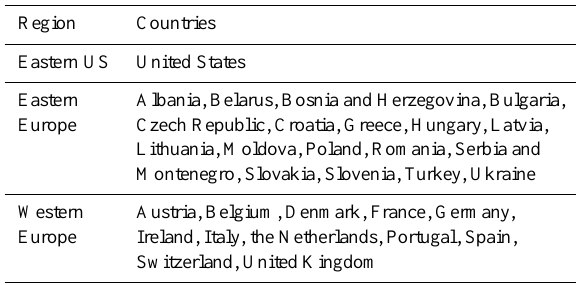
Table 2. List of countries included to calculate regional SO 2 emis- sion from the country-level emission data (countries with most parts inside the defined region) of S. J. Smith et al.